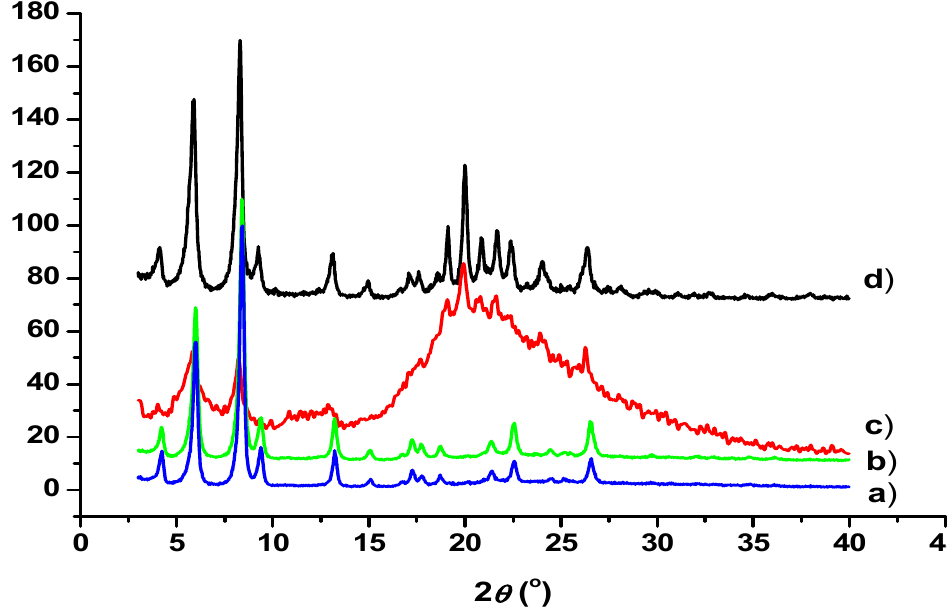
Figure 6. XRD pattern of dose-dependent polymerization of 1a/ DMF-H 2 O gel: ( a ) xerogel (0 kGy); ( b ) 30 kGy; ( c ) 50 kGy; ( d ) 1a powder (crystalline solid).